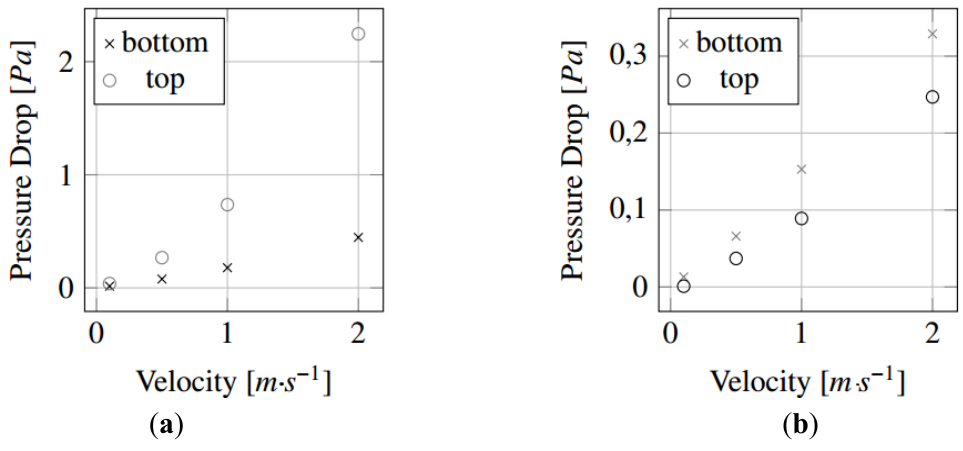
Figure 8. Different head loss profiles versus velocity, for cold ( a ) and hot period ( b ) of the regenerator. Top and bottom refer to different temperature conditions of fluids at the two sides of the